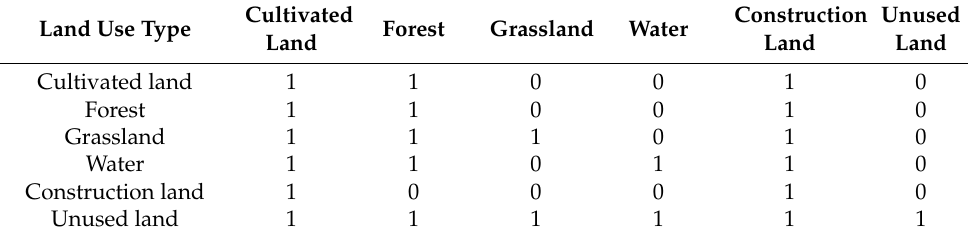
Table 2. Natural development scenario cost matrix.